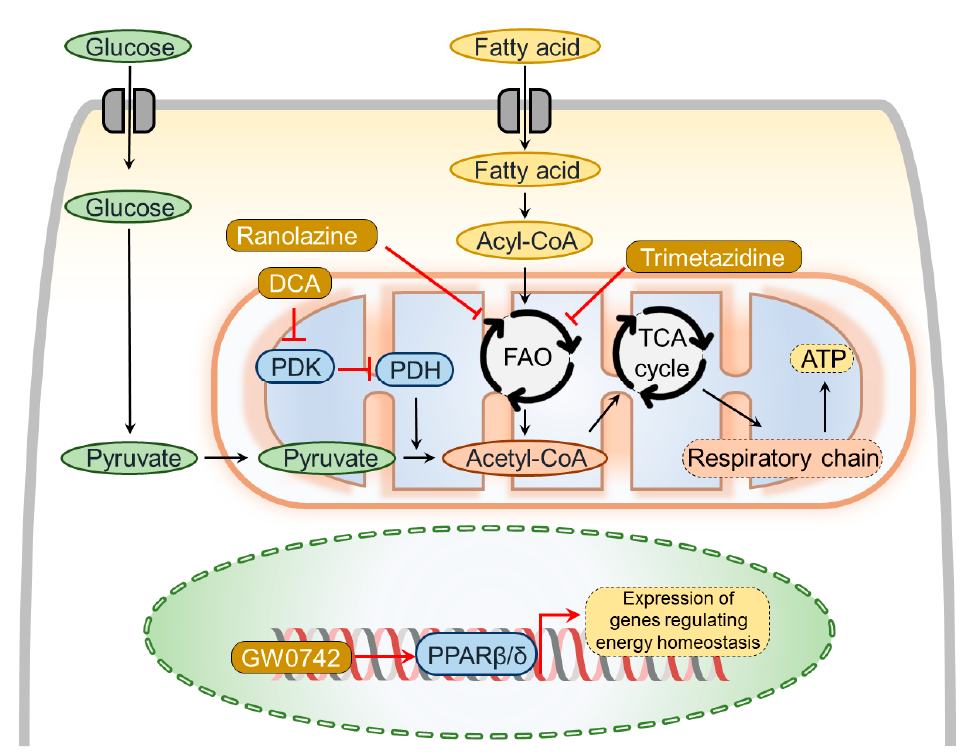
Figure 4. Mechanisms of agents improving metabolic alterations in pulmonary artery banding (PAB)-induced right ventricular (RV) remodeling. Dichloroacetate (DCA) inhibits pyruvate dehy- drogenase kinase (PDK), resulting in activation of pyruvate dehydrogenase (PDH), which allows pyruvate to enter the TCA cycle and promote glucose oxidation. While trimetazidine and ranolazine inhibit fatty acid oxidation (FAO), resulting in activation of glucose oxidation, GW0742 activates PPAR β / δ , which mediates the expression of genes regulating metabolic homeostasis. Cumulatively, these agents showed beneficial effects on the RV by improving metabolic